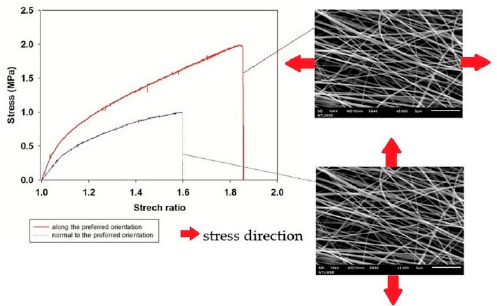
Figure 3. Stress–strain curve of fibroin/gelatin electrospun membrane. Red curve is the result when stress is along the preferred orientation. Blue curve is the result when stress is perpendicular to the preferred orientation.